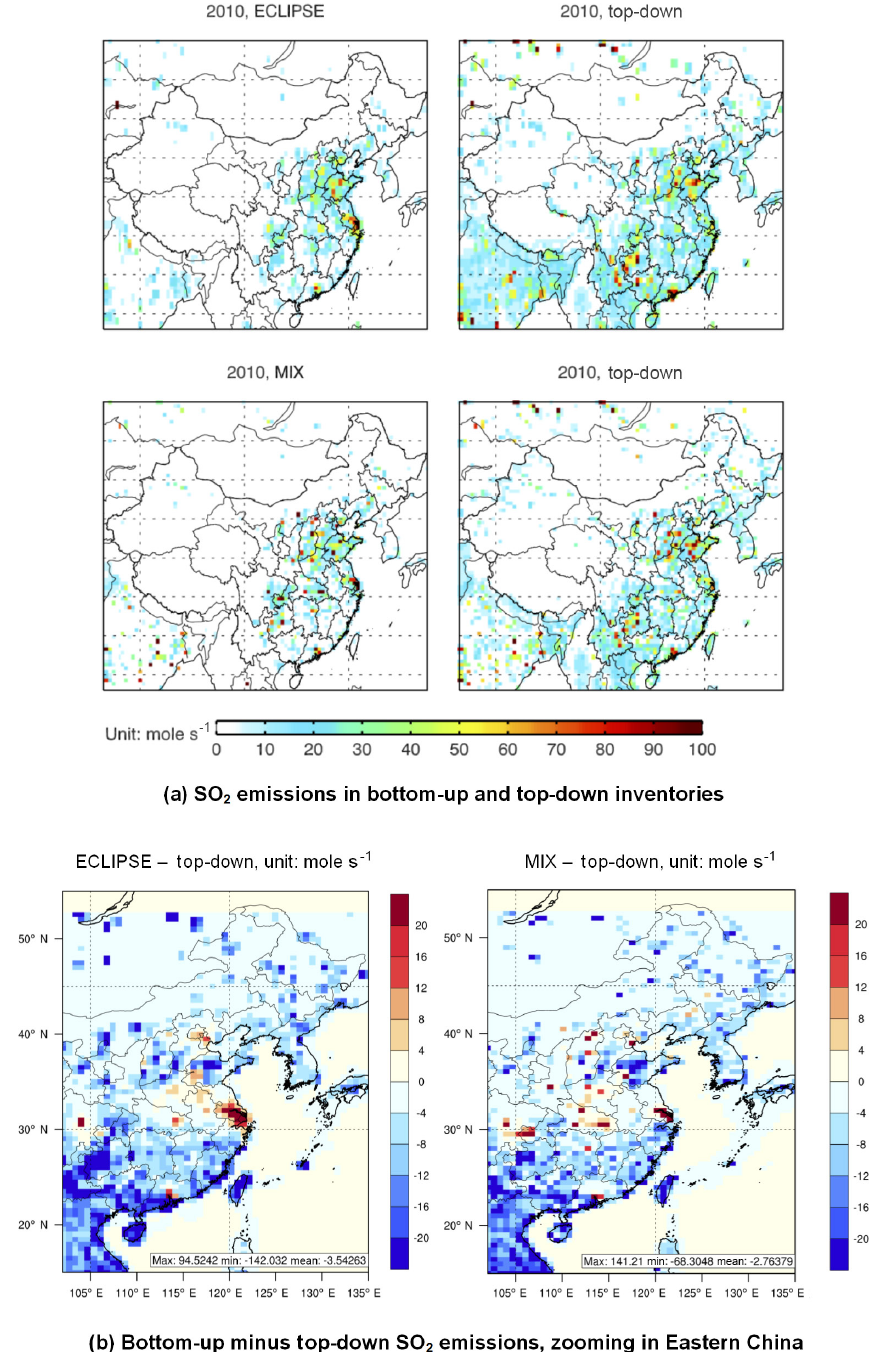
Figure 8. Comparisons among ECLIPSE, MIX and top-down emissions of SO 2 ; summer average in